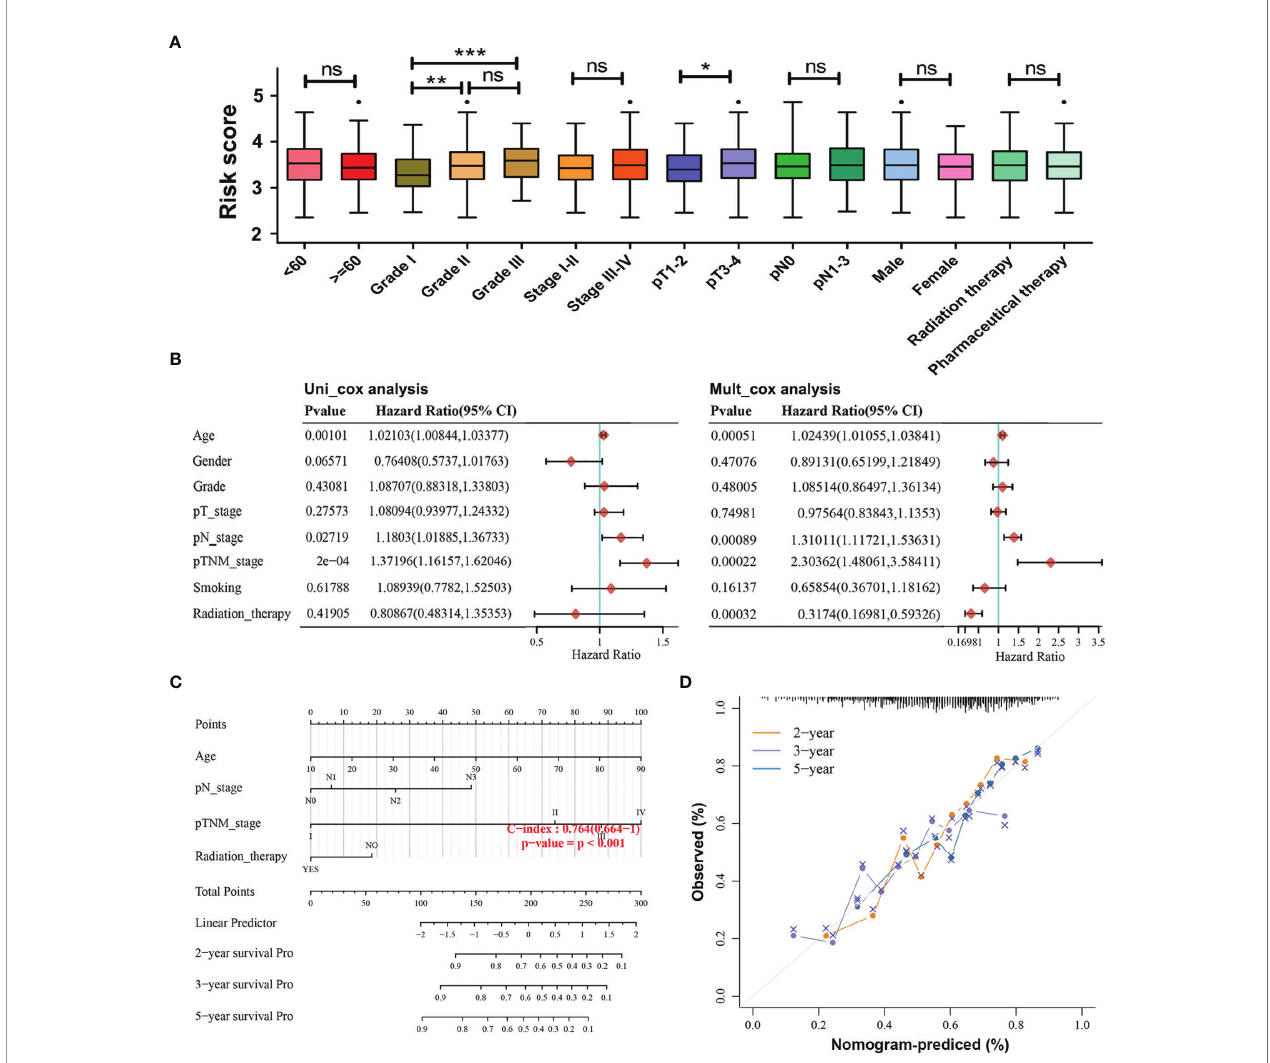
FIGURE 4 | Associations of the risk model with the overall survival and clinicopathological characteristics of HNSCC patients. (A) Relationships between the risk score and clinicopathological characteristics of HNSCC patients. (ns) Non-signi fi cant, * p < 0.05, ** p < 0.01, and *** p < 0.001. (B) Univariate and multivariate Cox analyses of clinical characteristics based on the training cohort. (C) The nomogram based on age, pathological N stage, pathological TNM stage, and radiation therapy for providing prognosis of HNSCC patients. (D) Calibration plots for the overall survival nomogram model. A dashed diagonal indicates the ideal nomogram, and the orange line, purple line, and blue line represent the predicted 2-year, 3-year, and 5-year overall survival of HNSCC